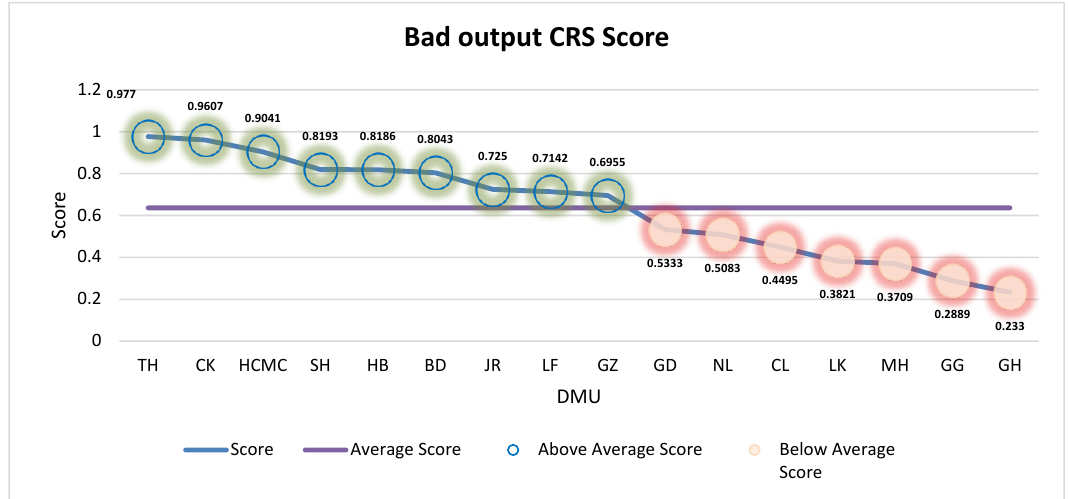
Figure 2. Bad-output CRS score for 16 locations in Asia.